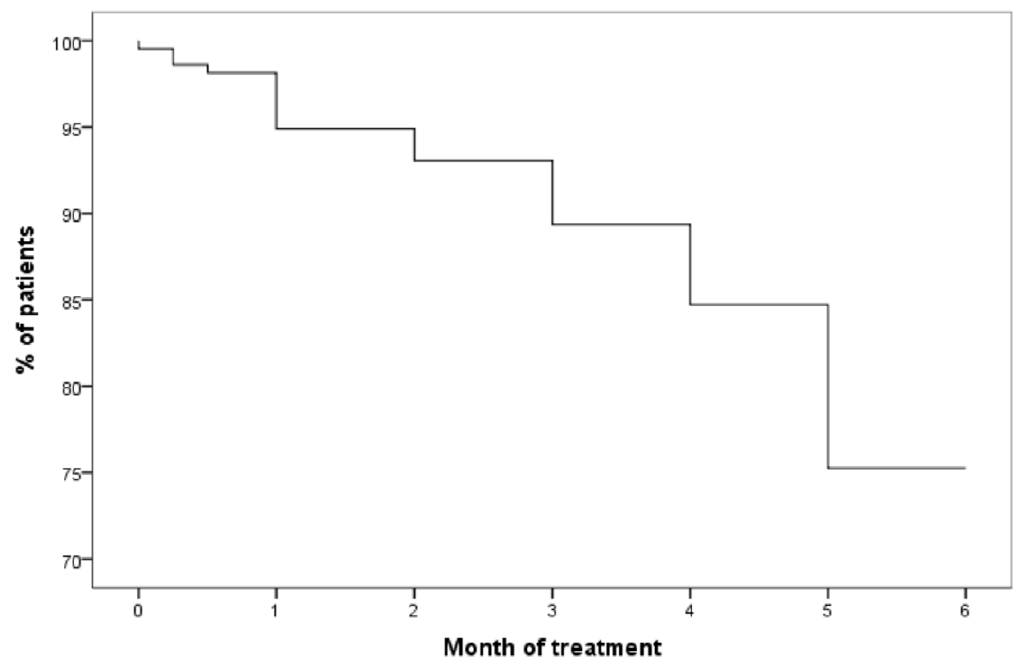
Figure 2. Completion of LTBI treatment. Percentage of patients completing treatment for LTBI by month.